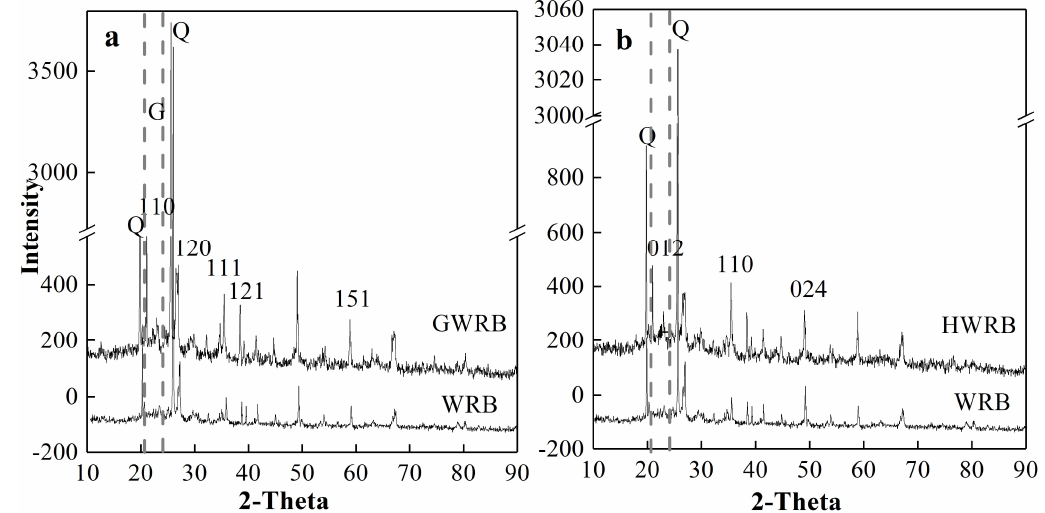
Figure 2. The X-ray di ff raction patterns of GWRB ( a ) and HWRB ( b